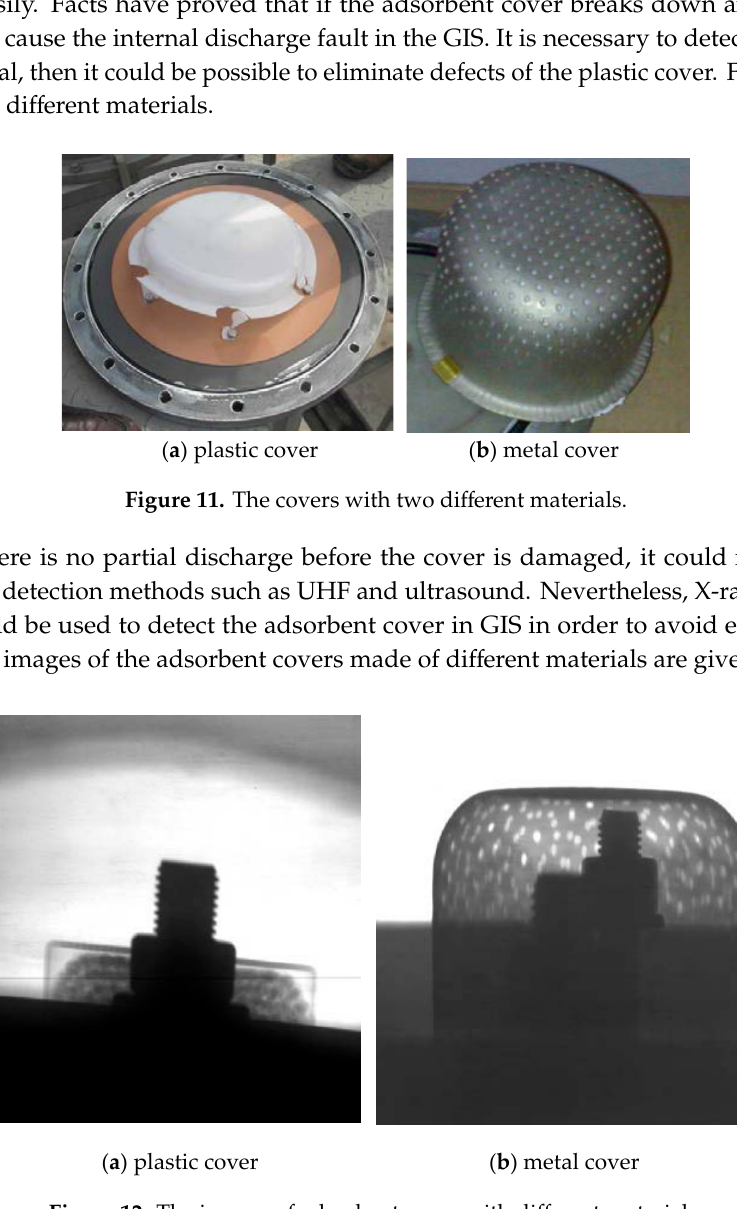
Figure 10. Non-metallic flaky particle.